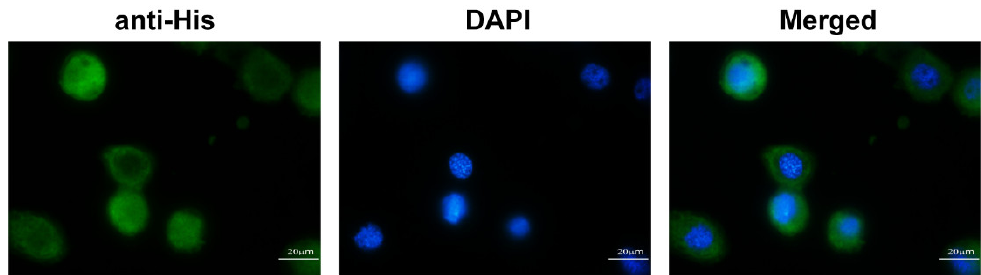
Figure 8. Subcellular localization of BmIML-2 in BmN cells. Cells were transfected with pIZ/V5-His- IML-2 and cultured for 48 h. Then, the cells were fixed, permeabilized, and stained. 4,6-Diamidino- 2-phenylindole (DAPI) labels nuclei, shown in blue ; Alexa-Flour-488-conjugated goat anti-mouse antibody labels BmIML-2, shown in green ; scale bar represents 20 µm.